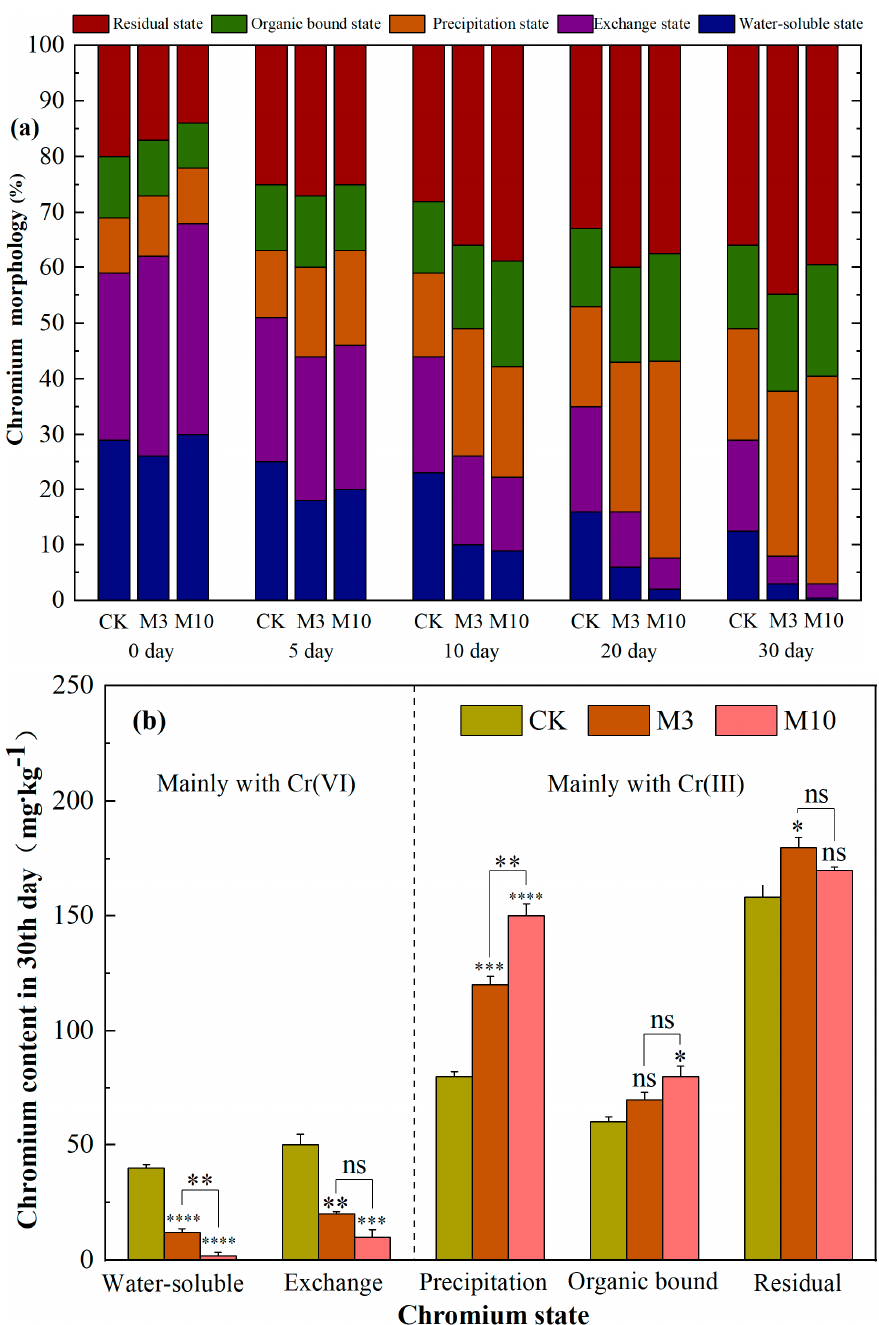
Figure 6. ( a ) Aspergillus niger drives the transformation of chromium form in red soil. ( b ) Chromium distribution in soil after A. niger inoculation. CK—control. (****, p < 0.0001; ***, 0.0001 < p < 0.001; **, 0.001 < p < 0.01; *, 0.01 < p < 0.05; ns, no significant difference). High-throughput sequencing was used to analyze soil microbial diversity in M10 and CK treatments after 30 d of A. niger inoculation. The results showed that the inoculation of A. niger significantly increased the abundance of A. niger in red soil with severe chromium pollution (Figure 7a). At the same time, after A. niger was inoculated, the total amount of fungi in the red soil did not change much, but the species changed greatly (Figure 7b).